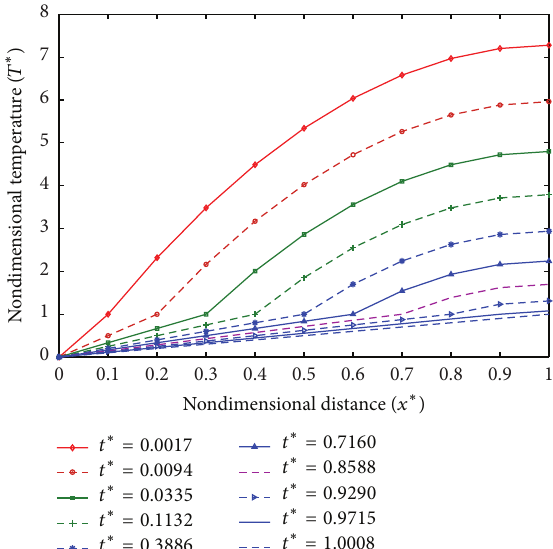
Figure 5: Temperature distribution at 𝑞 ∗ 𝑚 = 16.5